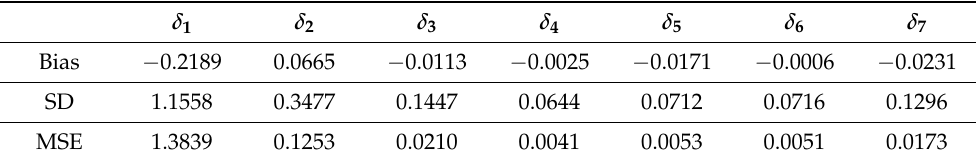
Table 12. Bias, SD and MSE evolutions with respect to the parameter δ variation for PLGSIMF with the logit link function and n =